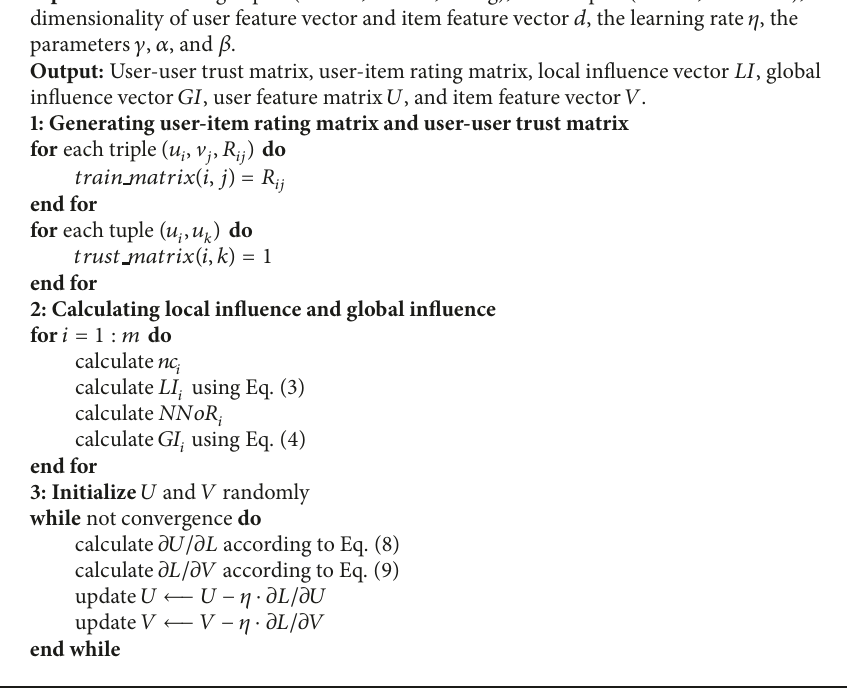
Algorithm 1: The proposed recommendation method RDISI with direct and indirect social